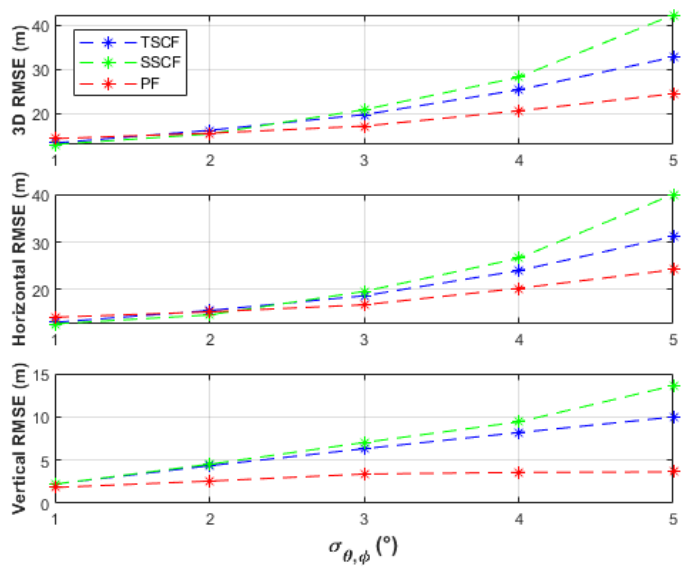
Figure 5. Performance comparison of the batch-processing solutions with certain UAS positions and using 101 measurement points.